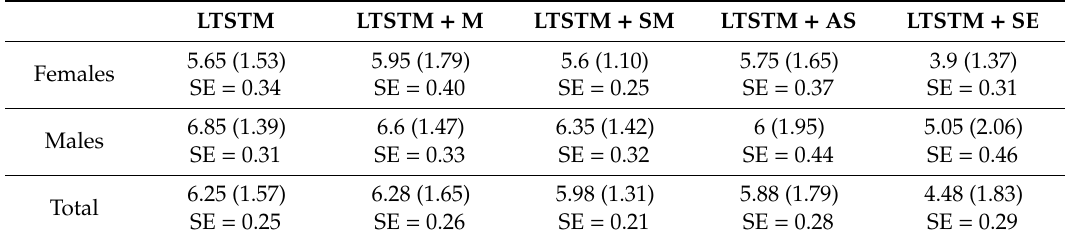
Table 1. Descriptive statistics: means (standard deviations) and standard errors (SE).